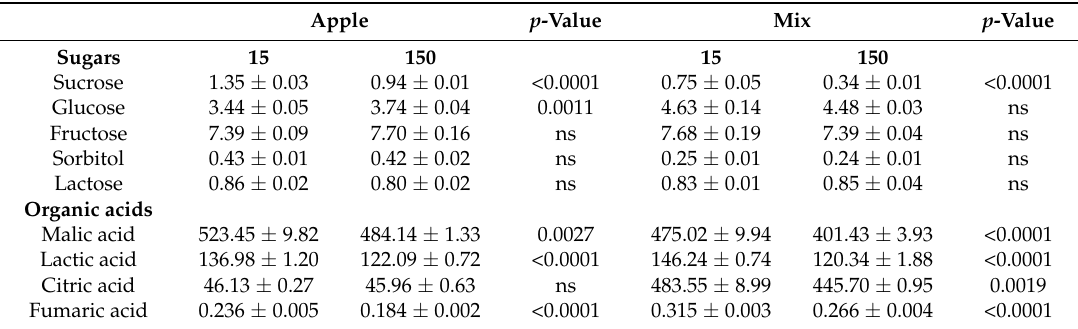
Table 4. Amounts of sugars (g/100 mL) and organic acids (mg/100 mL) of apple- and mix-RCW drinks after 15 and 150 days of storage. Apple p -Value Mix p